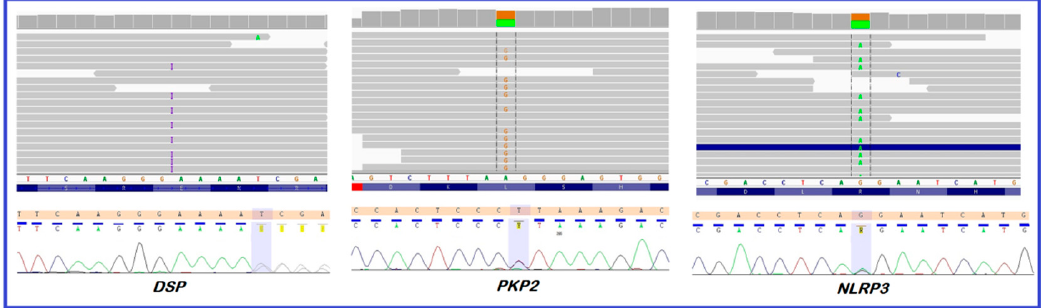
Figure 4. Integrated Genomic Viewer (IGV) views and electropherograms of the identified heterozygous variants: DSP NM_004415.4:c.3737dupA (p.Asn1246LysfsTer7), PKP2 NM_004572.3:c.2636T >